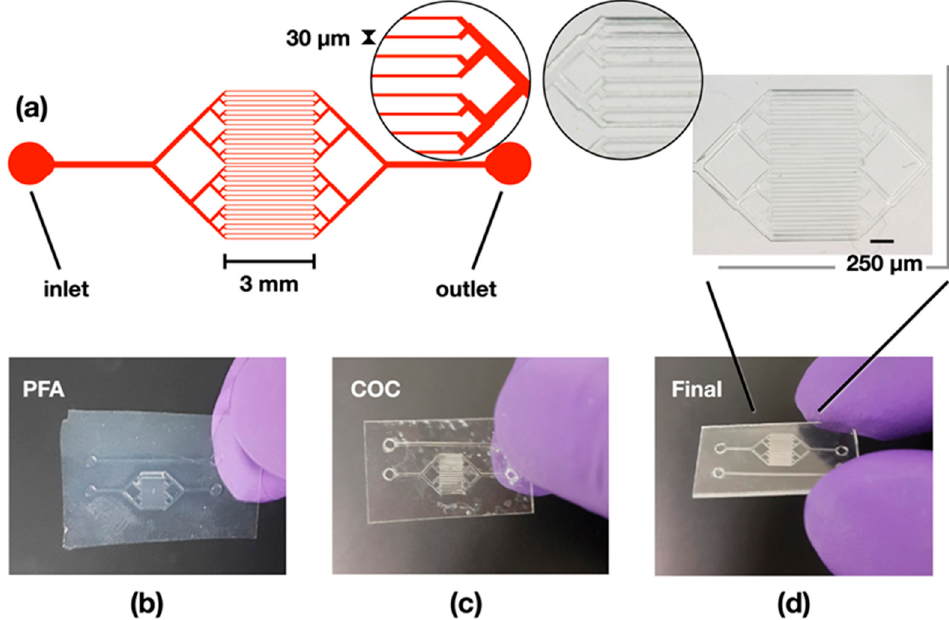
Figure 4. Stepwise fabrication of the microfluidic device setup. ( a ) Schematic representation of the MiD with the details of the dimensions for the channel cross-section (30 µm) and full length (3 mm) indicated in the diagram. The resulting parts of the manufacturing consist of ( b ) the PFA mold coming out of the PDMS, ( c ) the COC sheet with the PFA features, and ( d ) the final device after bonding the COC channels with the COC sheet. The inlet in ( d ) is a zoomed photo of the COC device, highlighting the details and small dimensions of the chip.